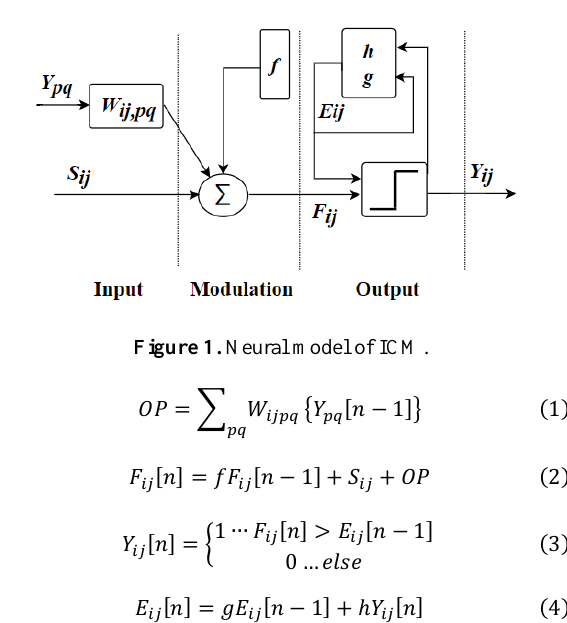
Figure 1. Neural model of ICM.